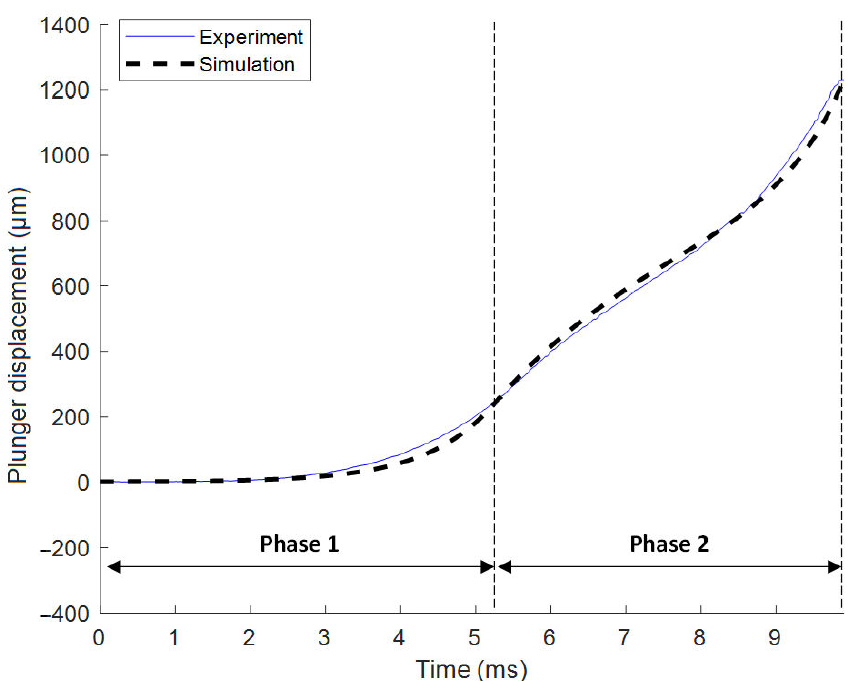
Figure 9. Comparison of displacements between the test and